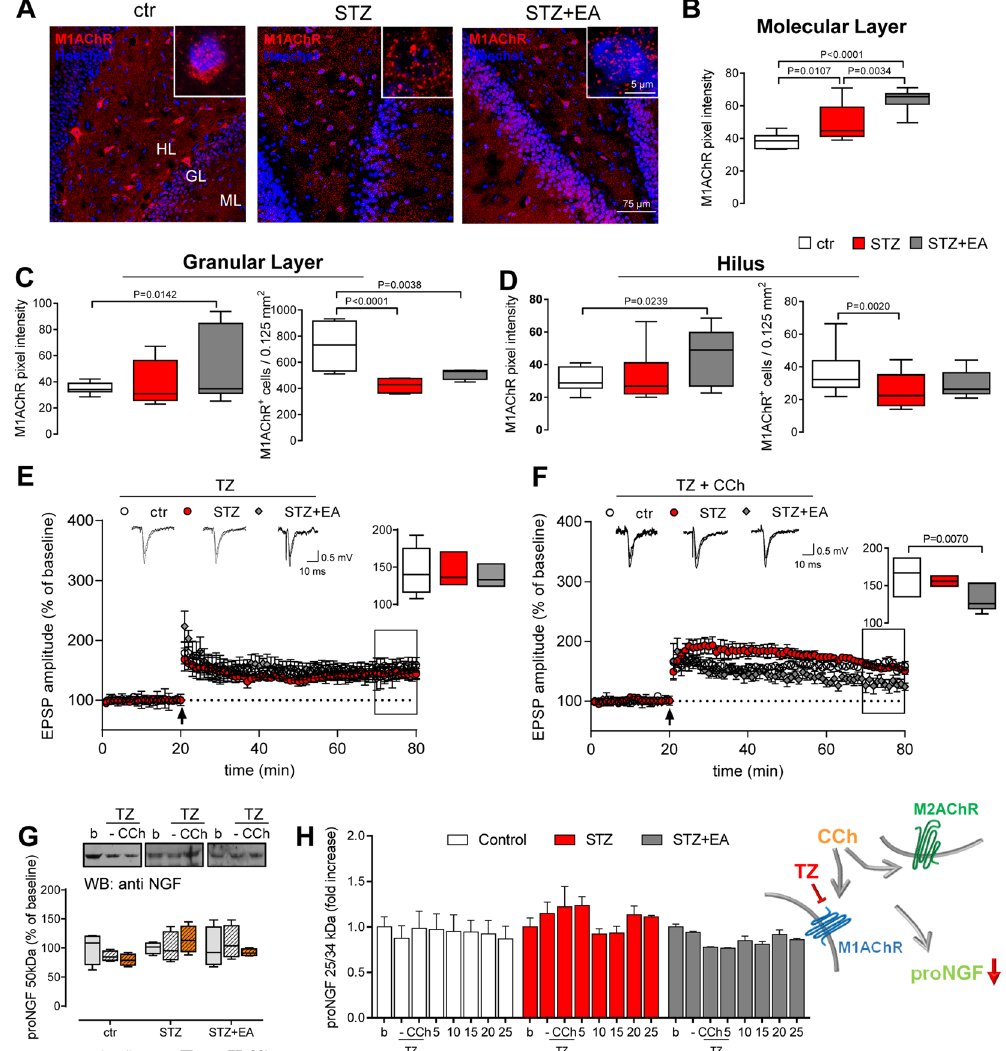
Figure 4. M1AChR tissue content and distribution is modified by diabetes and electroacupuncture and influences LTP and proNGF secretion. ( A ) Representative images of M1AChR immunolocalization in the dentate gyrus (DG). Insets: High-magnification details of M1AChR cellular distribution. ( B–D ) Mean pixel intensity and number of M1AChR immunopositive (M1AChR + ) cells in different areas of the DG. Means ± SEM (n = 8 fields, 4 animals for each experimental group). One-way ANOVA followed by Bonferroni multiple comparison test, P values shown in figure. ( E,F ) Long-term potentiation at dentate gyrus (DG-LTP) after stimulation of hippocampal slices with the M1AChR selective antagonist telenzepine (TZ) and the non- specific muscarinic agonist carbachol (CCh). Field excitatory postsynaptic potentials (fEPSP) were recorded and expressed as the percentage of the pre-tetanus baseline. Changes in fEPSP slopes before and 60 min after the induction of LTP by high-frequency stimulation (HFS) of the medial perforant pathway (black arrow) are shown (means ± SEM; n = 8 for each experimental group). The insets represent typical fEPSP recordings; calibration bars: 0.5 mV, 10 ms. The average of DG-LTP magnitude 50–60 min after HFS is presented on the right side of the panels (median ± interquartile range, whiskers: min. and max.). One-way ANOVA and Bonferroni multiple comparison (P values shown in figure). ( G ) Carbachol-stimulated proNGF release from hippocampal slices. Telenzepine was added to the superfusion bath before hippocampal slices were exposed to carbachol. Densitometry of the Western blots (cropped representatives shown in the upper side of the panel; full-length blots are shown in online Supplementary material) illustrates the differences in the telenzepine/ carbachol-stimulated proNGF release among the three experimental groups. Data are expressed as percentage of the respective baselines (median ± interquartile range, whiskers: min. and max.; n = 6 for each experimental group). Repeated-measure ANOVA followed by Bonferroni multiple comparison; P values shown in figure. ( H ) Carbachol-stimulated 25/34 kDa proNGF release from hippocampal slices measured by proNGF ELISA. Telenzepine was added to the superfusion bath before hippocampal slices were exposed to carbachol. Data, representing the percentage of the respective baseline means, are expressed as means ± SEM (n = 6 for each experimental group). Repeated-measure ANOVA followed by Bonferroni multiple comparison; P values shown in figure. Abbreviations: ML-molecular layer, GL-granular layer, HL-hilus, b-baseline,